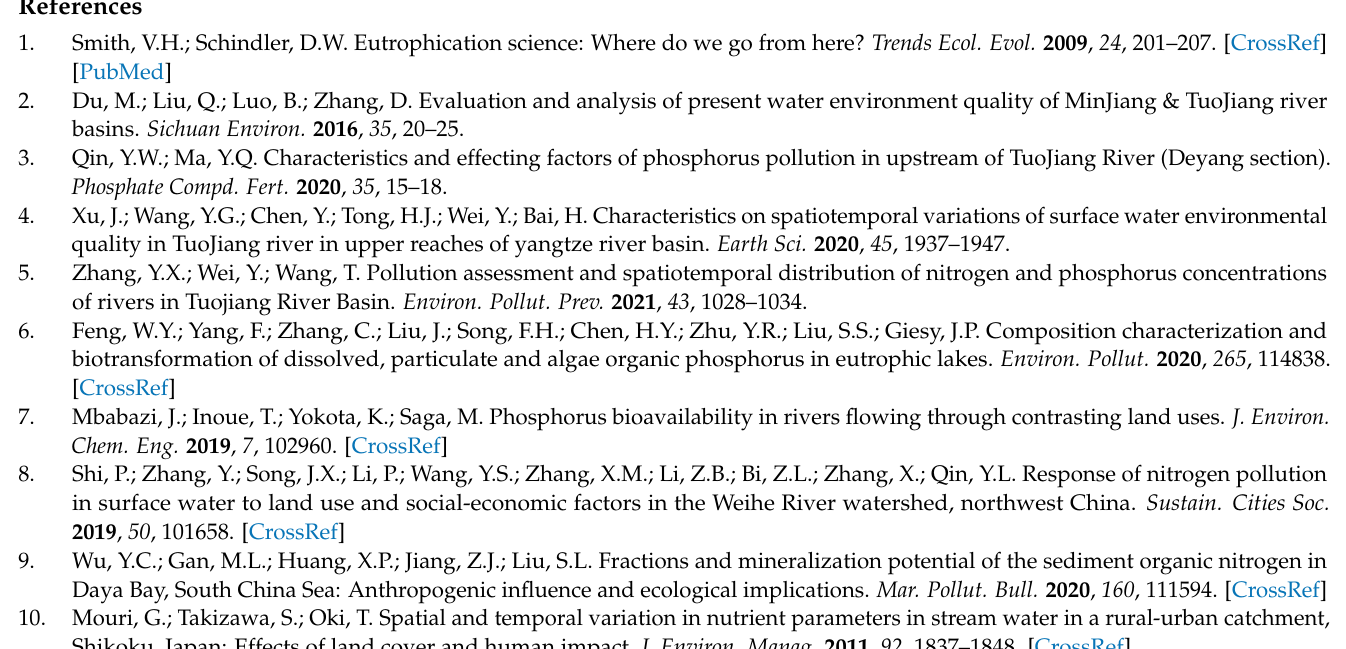
Table S3. Evaluation standard of nitrogen and phosphorus pollution in sediments. Table S4. The concentrations of total nitrogen and phosphorus and their fractions concentration in water. Table S5. The content of total nitrogen and phosphorus and their fractions in surface